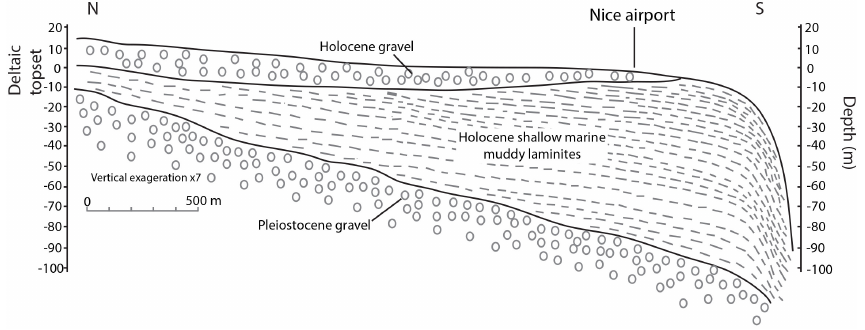
Figure 6. Schematic N–S cross-section of the Var delta deposits (on- and offshore). Figure modified after Dubar and Anthony (1995) and Dan et al.